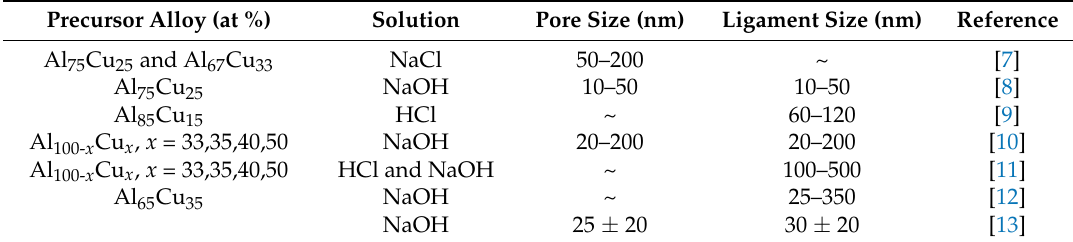
Table 1. Summary of NPC from Al-Cu binary